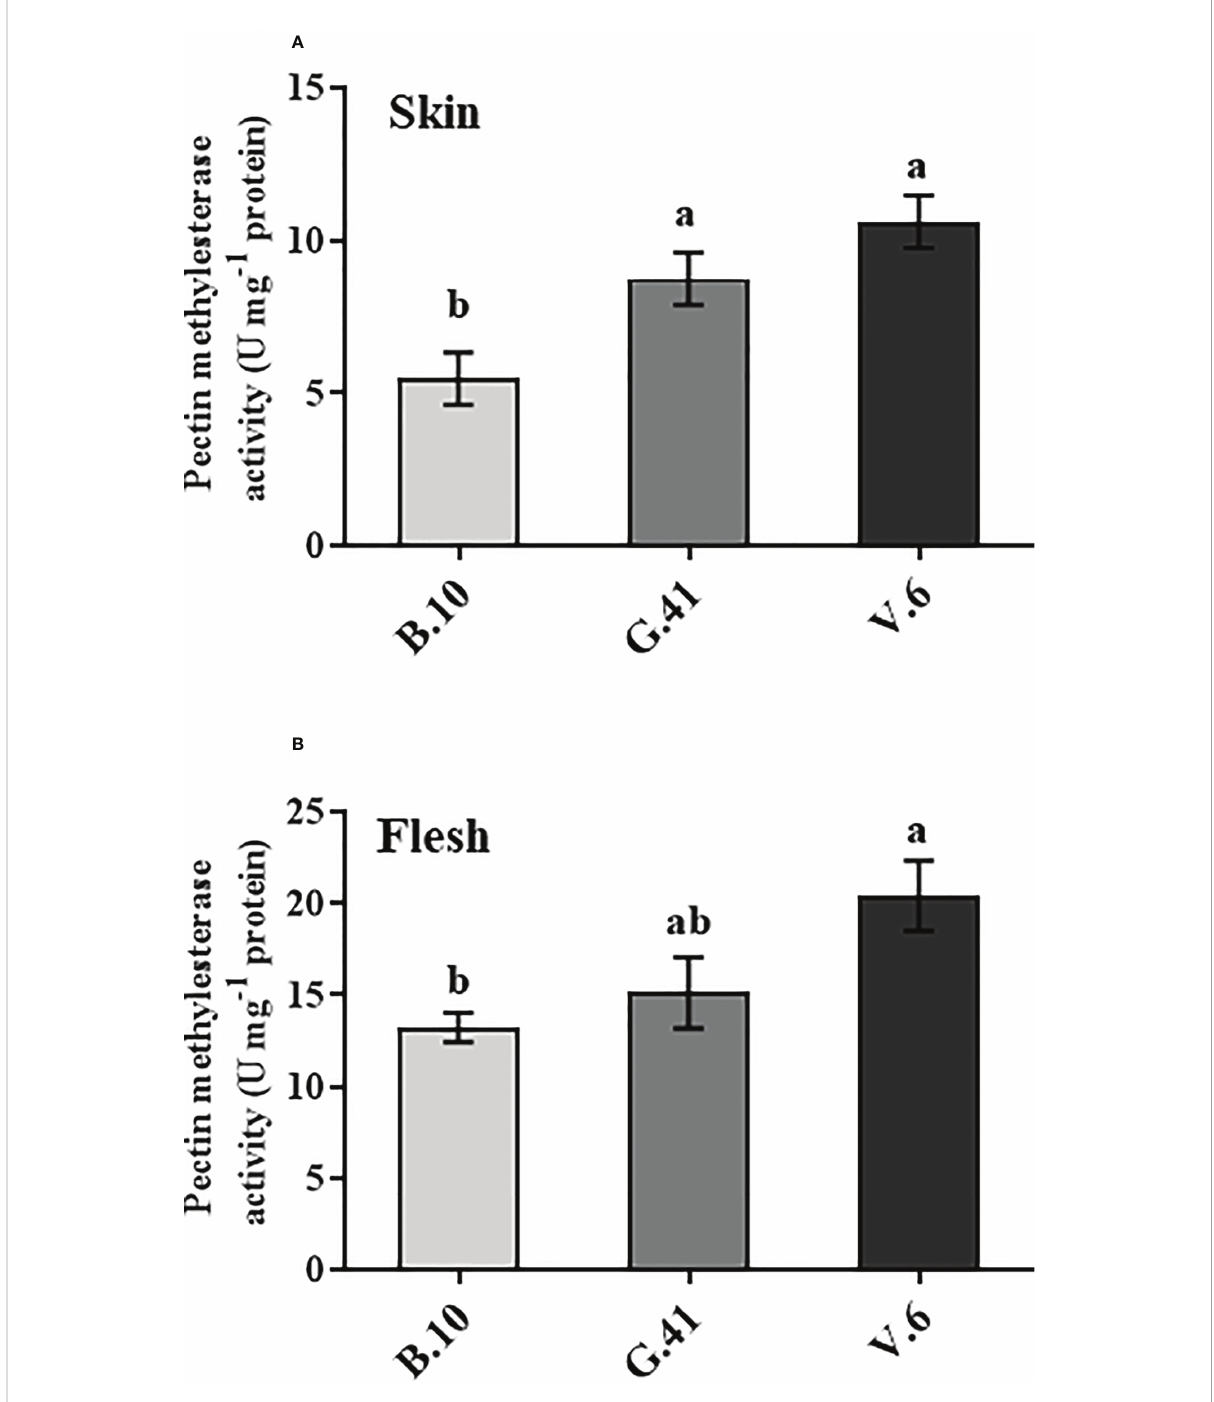
FIGURE 6 Pectin methyl esterase (PME) enzyme activity in ‘ Honeycrisp ’ apples from different rootstocks. The PME activity in the skin (A) and fl esh (B) tissues of apples from B.10, G.41, and V.6 after two months of cold storage. Means not sharing any letter are signi fi cantly different at P < 0.05, according to Tukey ’ s HSD